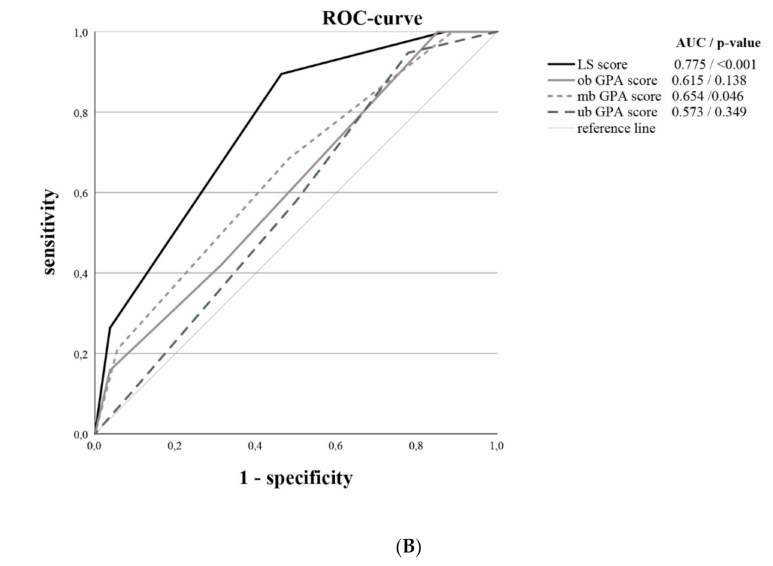
Figure 3. The receiver operating characteristic curves (ROC) demonstrate the diagnostic accuracy of different scores with regard to the prediction of short survival ( A ) and long survival ( B ) in BCBM patients. ( A ): demonstrated the SS-score and different GPA scores (inversed) for short survival (6 months survival). ( B ): demonstrated the LS-score and different GPA scores for long survival (3 years survival). Abbreviations: LS: long survival, SS: short survival, GPA: Graded Prognostic Assessment,